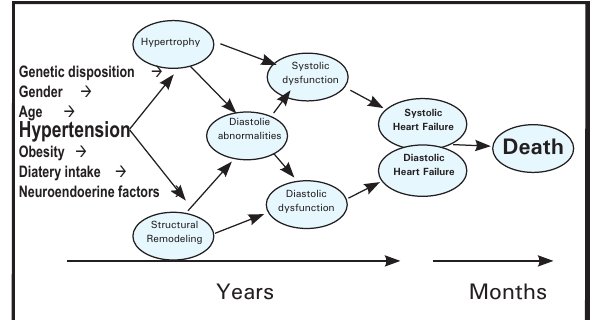
Figure 1. Progression from hypertrophy to diastolic heart failure. Several cardiovascular risk factors are associated with the occurrence of LV hypertrophy and structural remodeling. At the initial stage dias- tolic abnormalities are present with maintained sys- tolic and diastolic function. During follow-up, systolic and diastolic dysfunction occur and are associated either systolic pump or diastolic filling failure. In the presence of congestive symptoms the time course of heart failure may become progressive and may end with sudden cardiac death or intractable end-stage